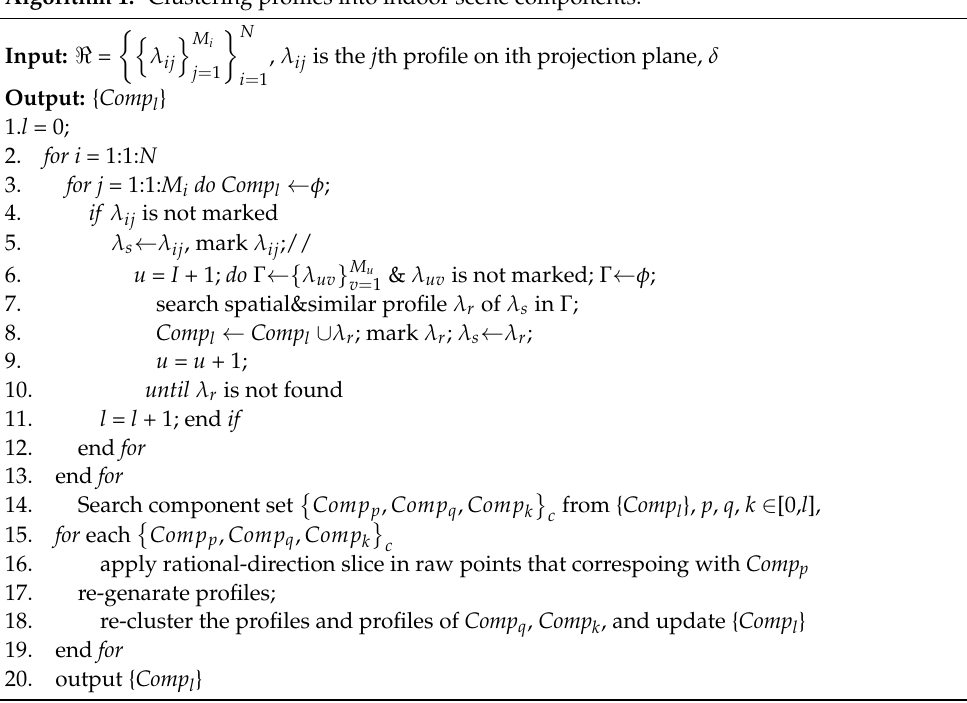
Figure 6. Adjustment of slicing: ( a ) The initial segmentation result; ( b ) rotated slicing planes; ( c ) the final results. Algorithm 1. Clustering profiles into indoor scene